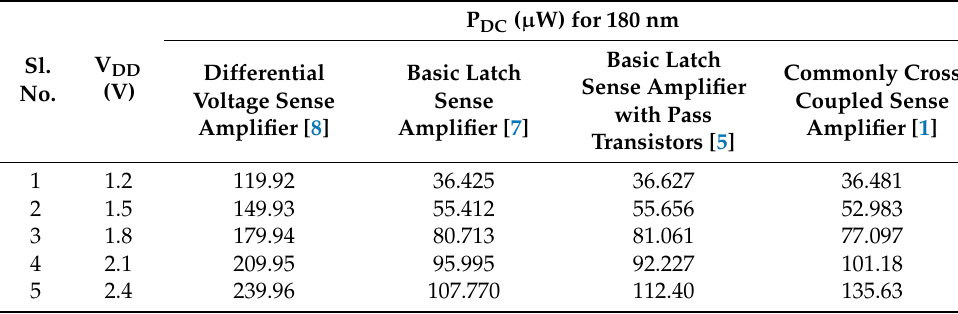
Table 1. Comparison of average power consumption with varying supply voltage for different sense